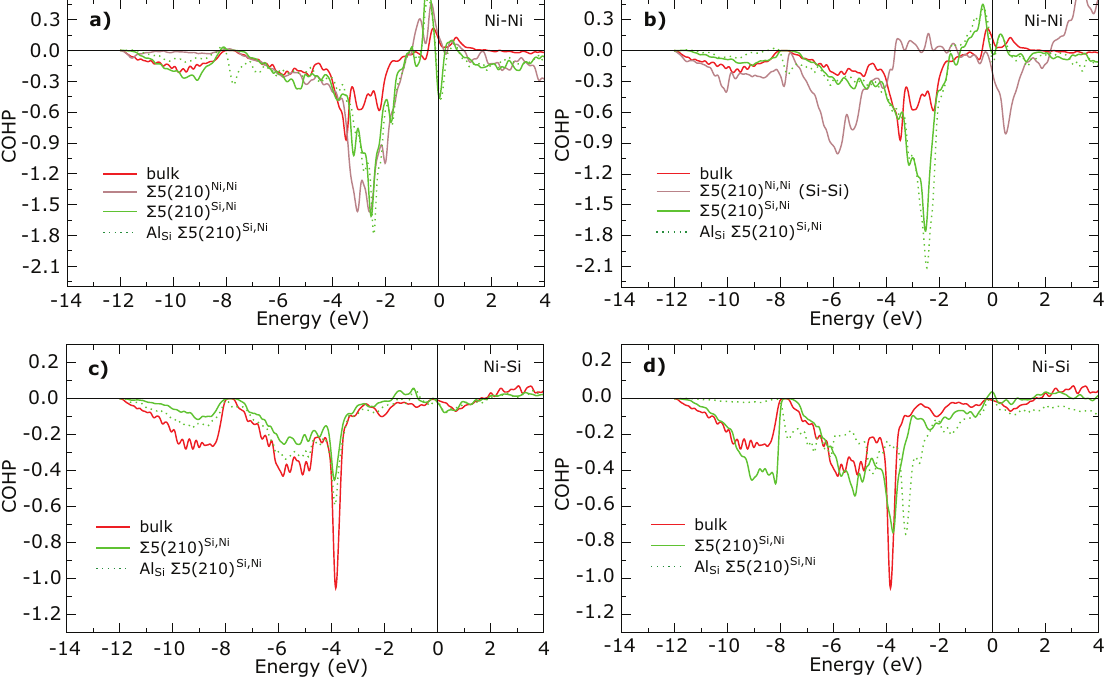
Figure 8. COHP curves for selected interatomic interactions in GBs and corresponding interactions in the bulk. ( a ) Interaction across the GB of Ni–Ni atoms from Ni plane between both 2nd layers (marked by a black arrow in other figures). ( b ) Interaction across the GB of Ni–Ni (Si–Si) atoms from NiSi plane between both 2nd layers (marked by black arrows in other figures). ( c ) Interaction of Ni–Si atoms between the 3rd and 5th layer (marked by red arrows in other figures). ( d ) Interaction of Ni–Si(Al) atoms between the GB and the 3rd layer (marked by cyan arrows in other